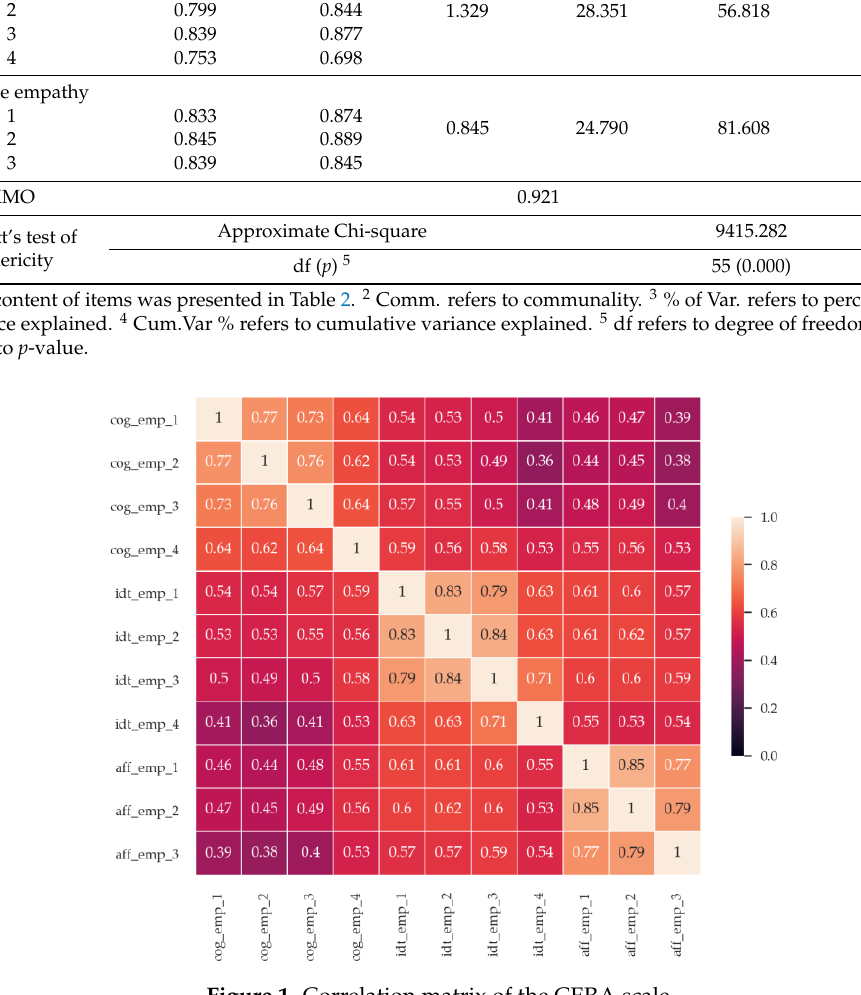
Figure 1. Correlation matrix of the CERA scale.